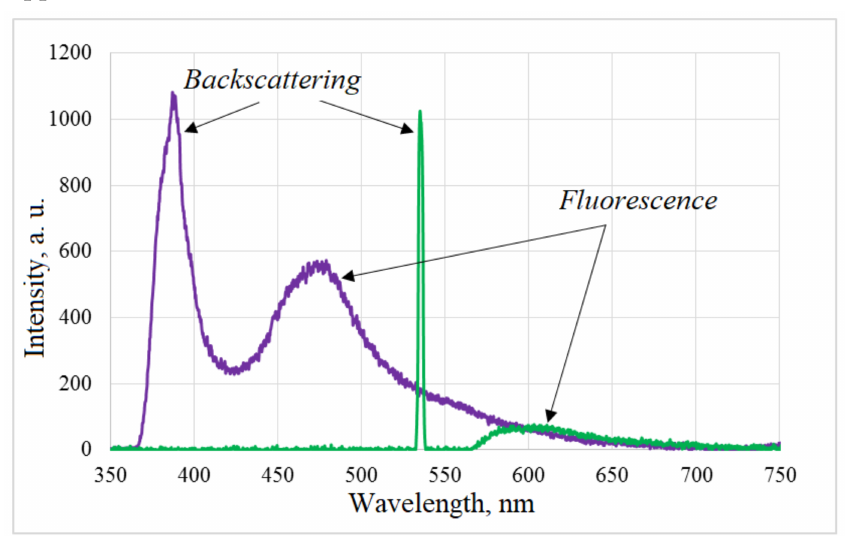
Figure A3. Examples of registered fluorescence spectra at λ e = 365 nm and λ e = 535